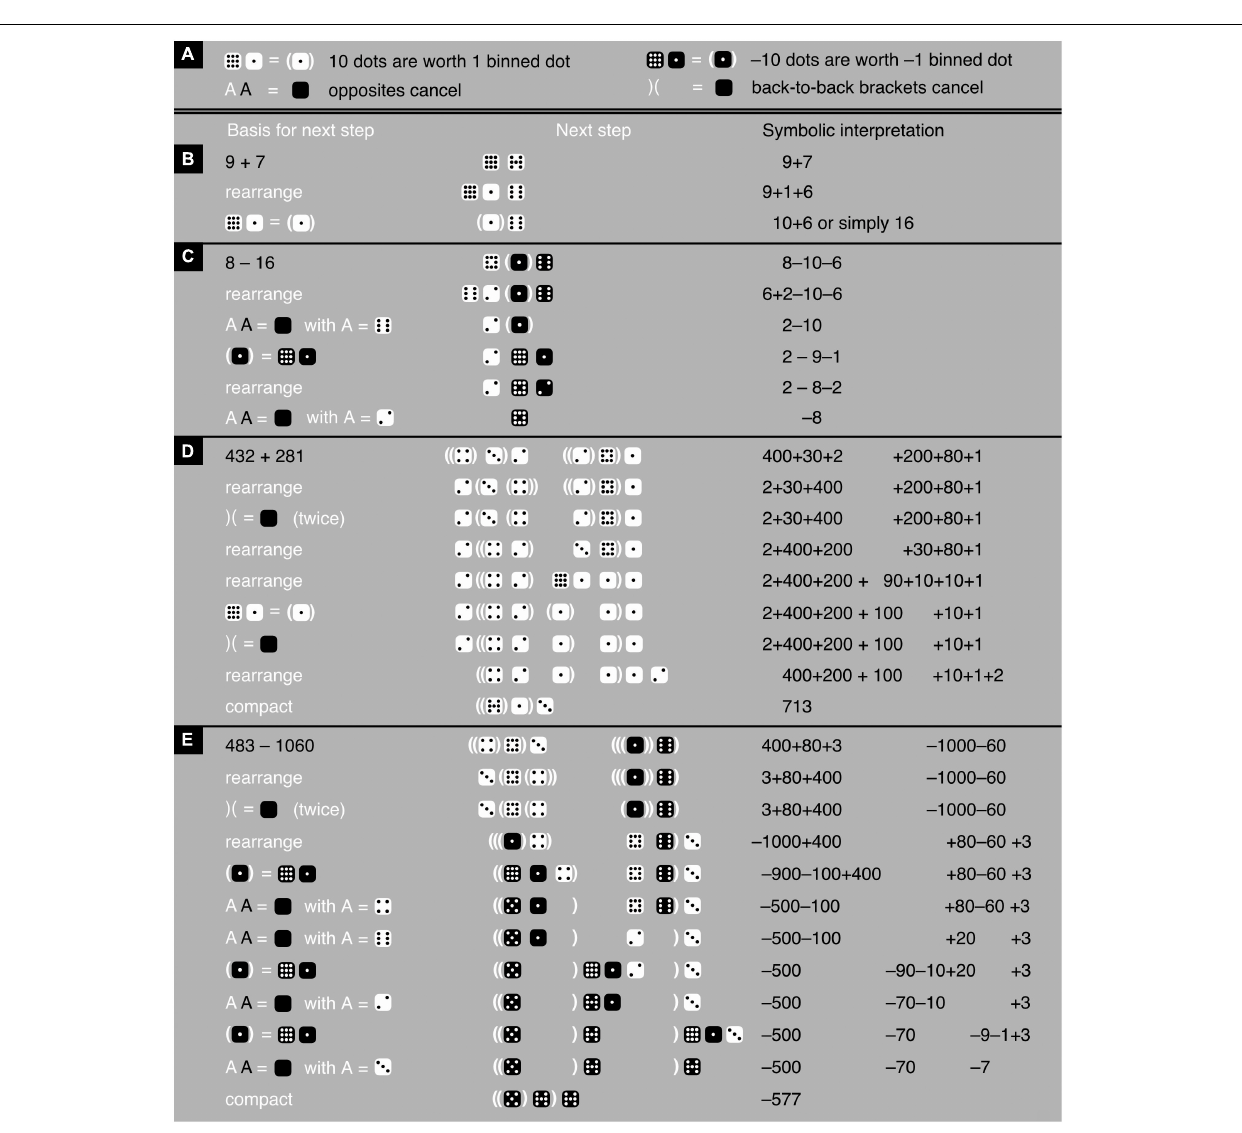
is often abbreviated to log, and so, log(10) = 1, log(100) =